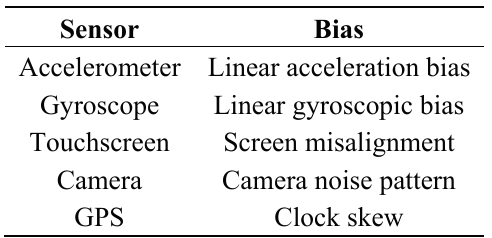
Table 1. Sensors and their associated bias.